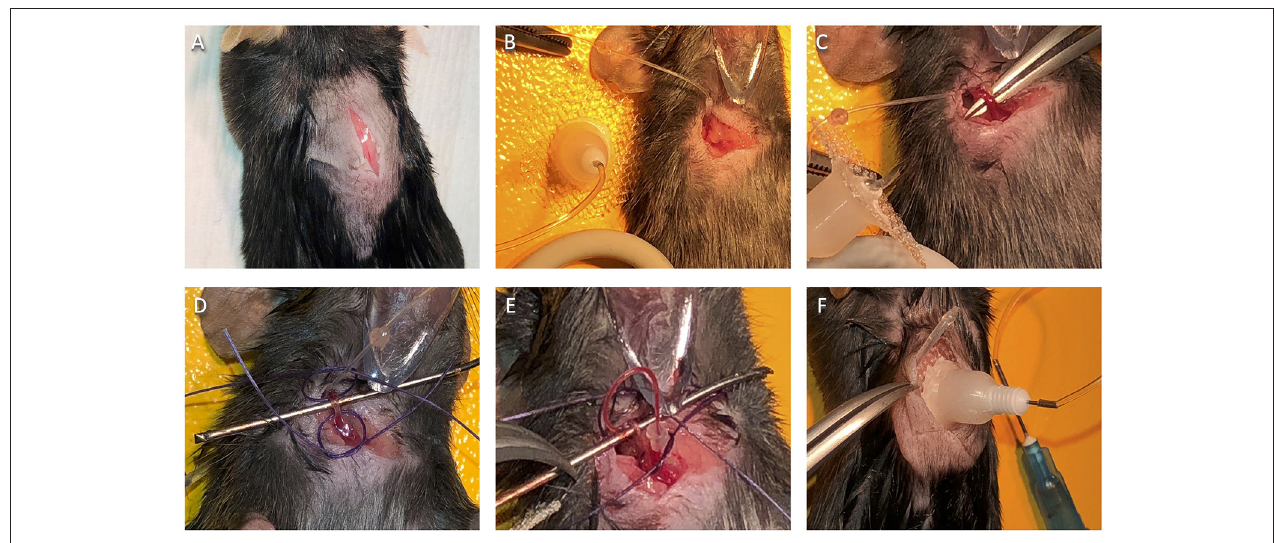
FIGURE 4 | Jugular vein catheter implantation surgery. (A) Placement of initial dorsal side incision. (B) Catheter placement after successful ventral to dorsal tunnel. (C) Isolated jugular vein. (D) Jugular vein with suture loops in place, ready for veinous incision. (E) Successful catheter placement in the jugular vein. (F) Positioning of catheter base on the dorsal side.